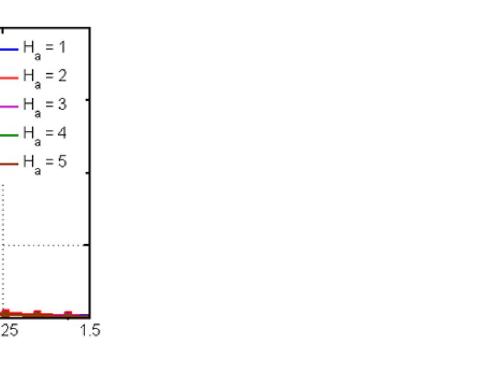
Figure 4. Variation in velocity profile for diverse values of